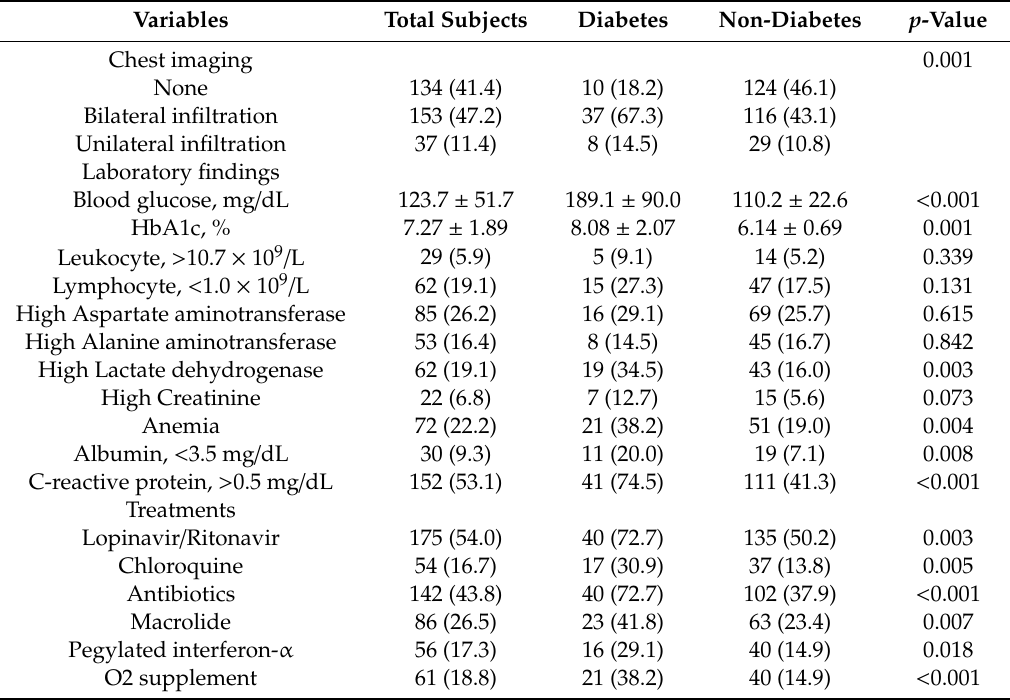
Table 2. Chest imaging findings, laboratory characteristics, and treatments.